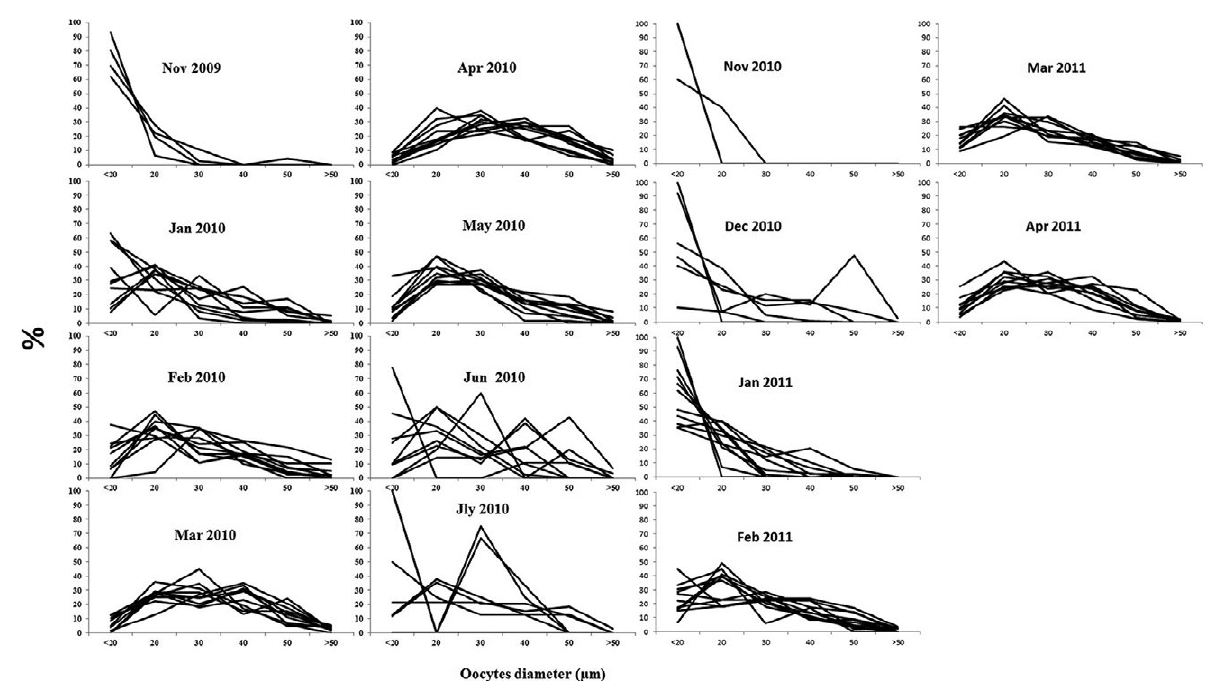
Fig. 7. – Monthly variation in the frequency distributions of oocyte diameter in females of A. tuberculata.